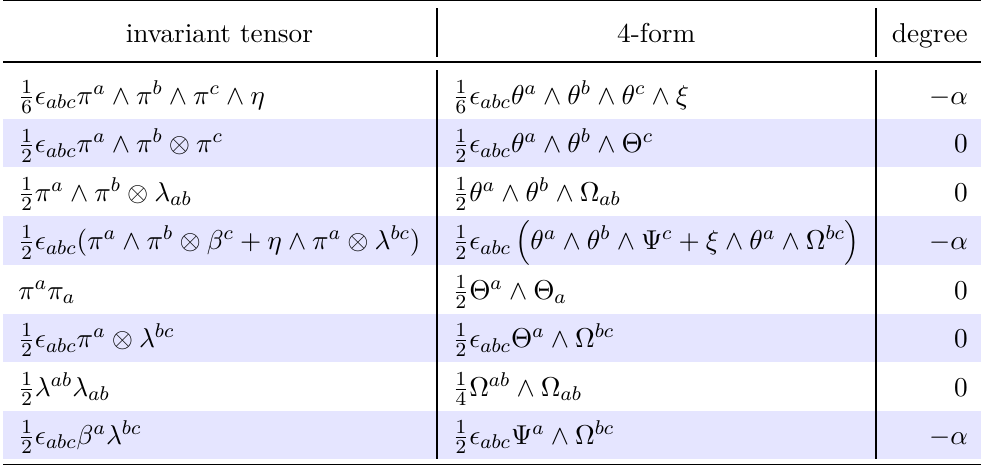
Table 8 . h -invariant tensors and the corresponding gauge-invariant 4